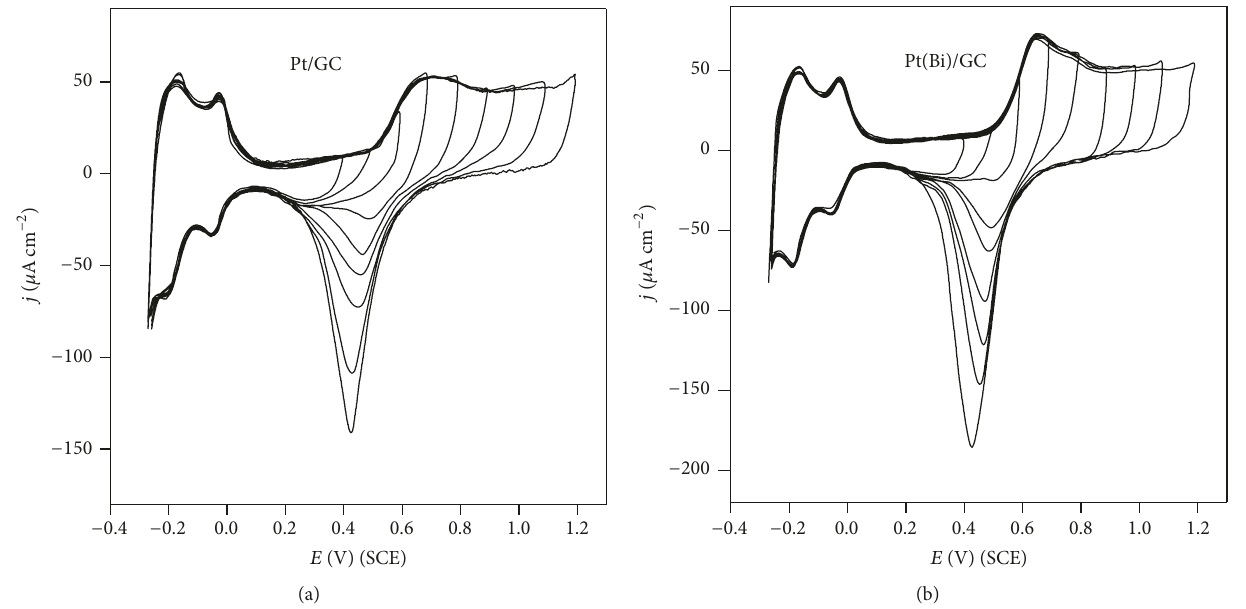
Figure 1: CVs on Pt/C (a) and Pt(Bi)/GC (b) electrodes in 0.1M H 2 SO 4 at 50 mVs – 1 and 𝜛 = 1500 rpm for successive increases of the forward potential scan limit.